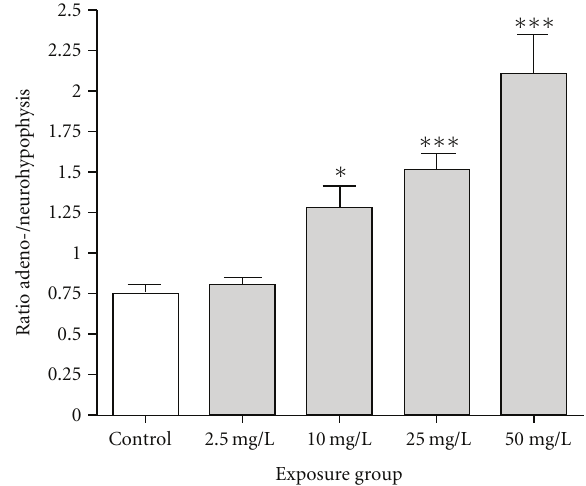
Figure 9: Ratio of adeno- to neurohypophyseal tissue of zebrafish ( Danio rerio ) after exposure to 0, 2.5, 10, 25, and 50mg/L PTU. Measurements were performed with 60 animals after 35 days of exposure. Asterisks indicate significant di ff erences between exposure and control groups ( ∗ P < 0 . 05, ∗∗∗ P < 0 . 001; Dunn’s